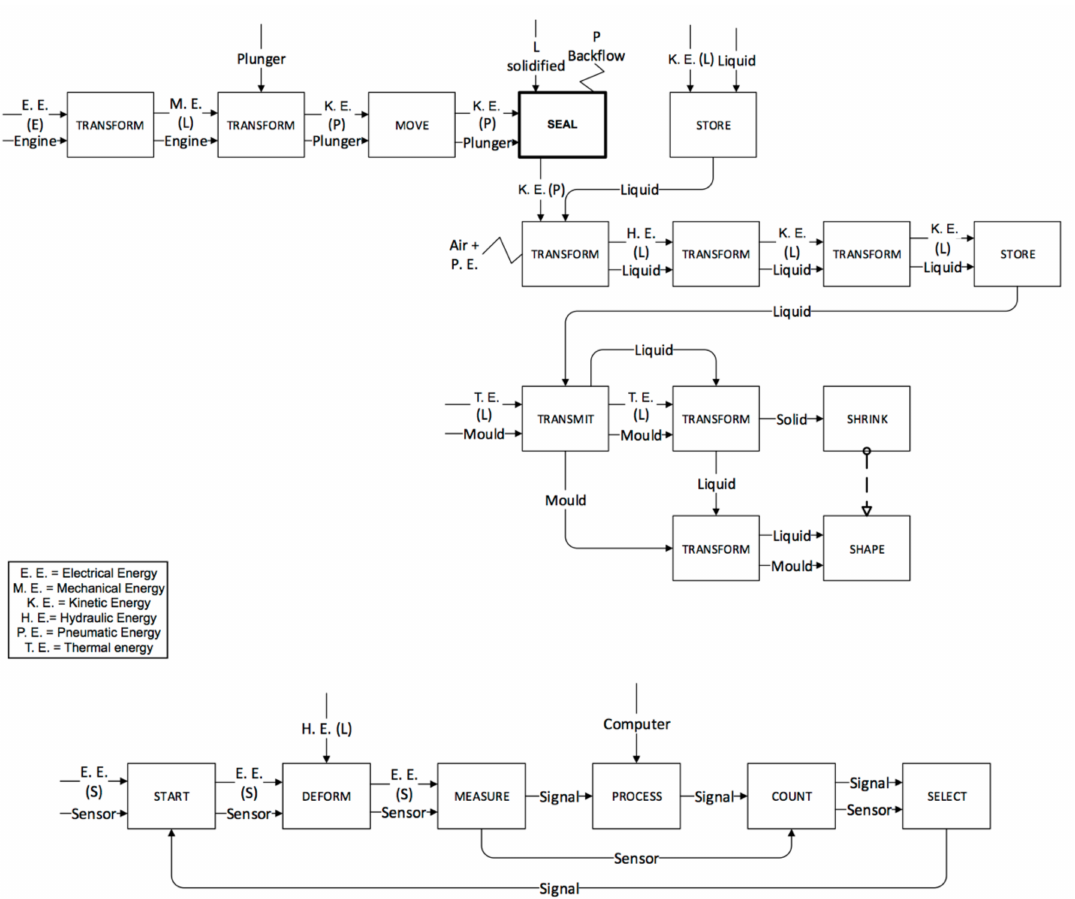
Figure 12. Injection and packing phases for the µ IM machine.